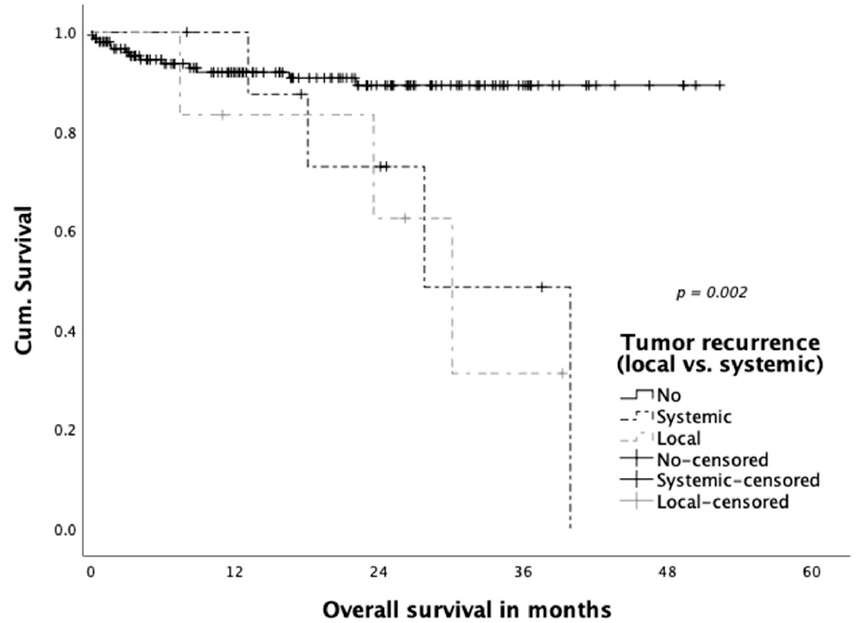
Figure 6. Overall survival according to site of tumor recurrence (local/systemic). A total of fourteen percent of the patients died within the observational period. A total of 6.3% of the deaths were cancer related, 2.5% were not cancer related, three patients (1.9%) died postoperatively (30-day mortality) and, in 3.2%, cause of death could not be determined. Overall survival is shown in Figure 7. Overall survival was 92.0% after 12 months and 82.2% after 36 months.